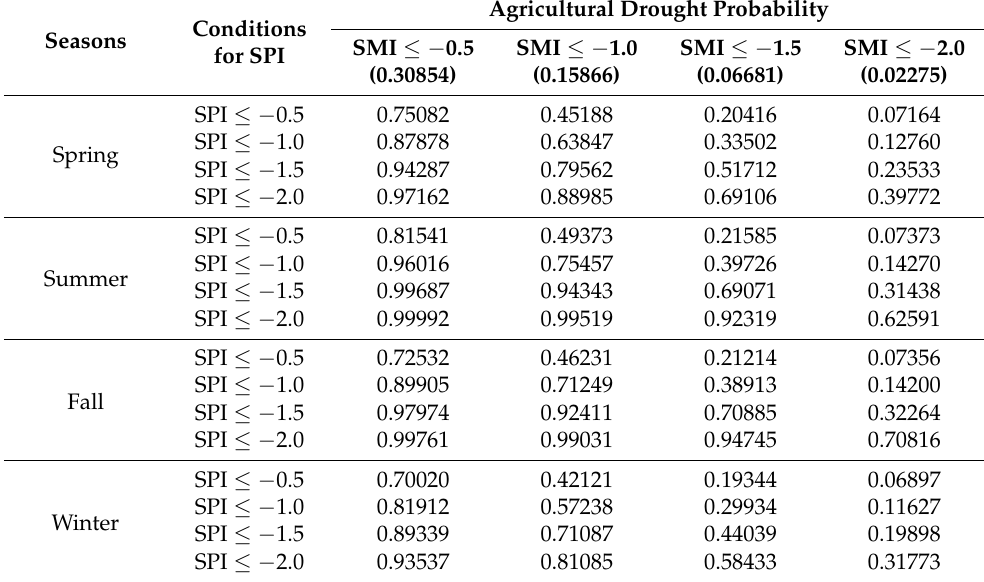
Table 4. Propagation probability of agricultural drought under various seventies of meteorological drought at Hapcheon Dam